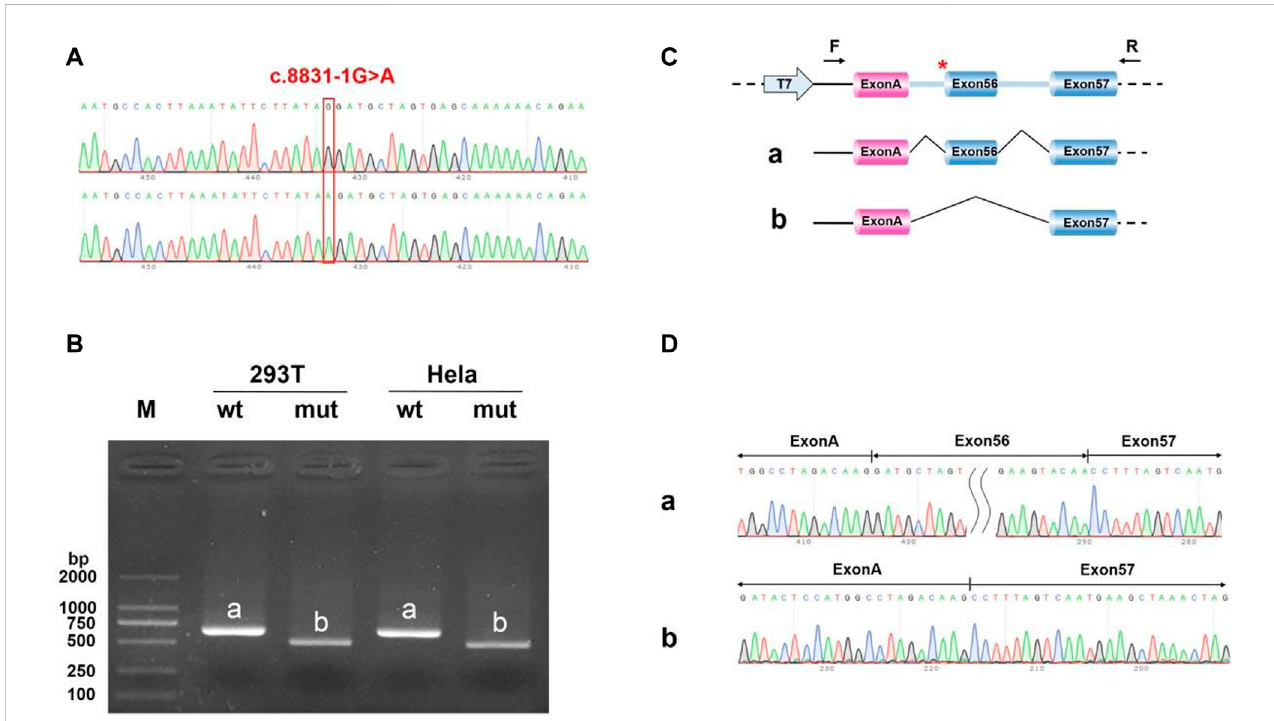
FIGURE 12 Minigene analysis based on pcMINI-C- DYNC2H1 -wt/mut recombinant vector (A) Sanger sequencing results of the recombinant vector. (B) Electrophoresis results of transcript PCR products in both 293T and HeLa cell lines. (C) A schematic splicing mechanism of the DYNC2H1 c.8833-1G > A variant. (D) Sanger sequencing of PCR products. Red * indicates the mutation